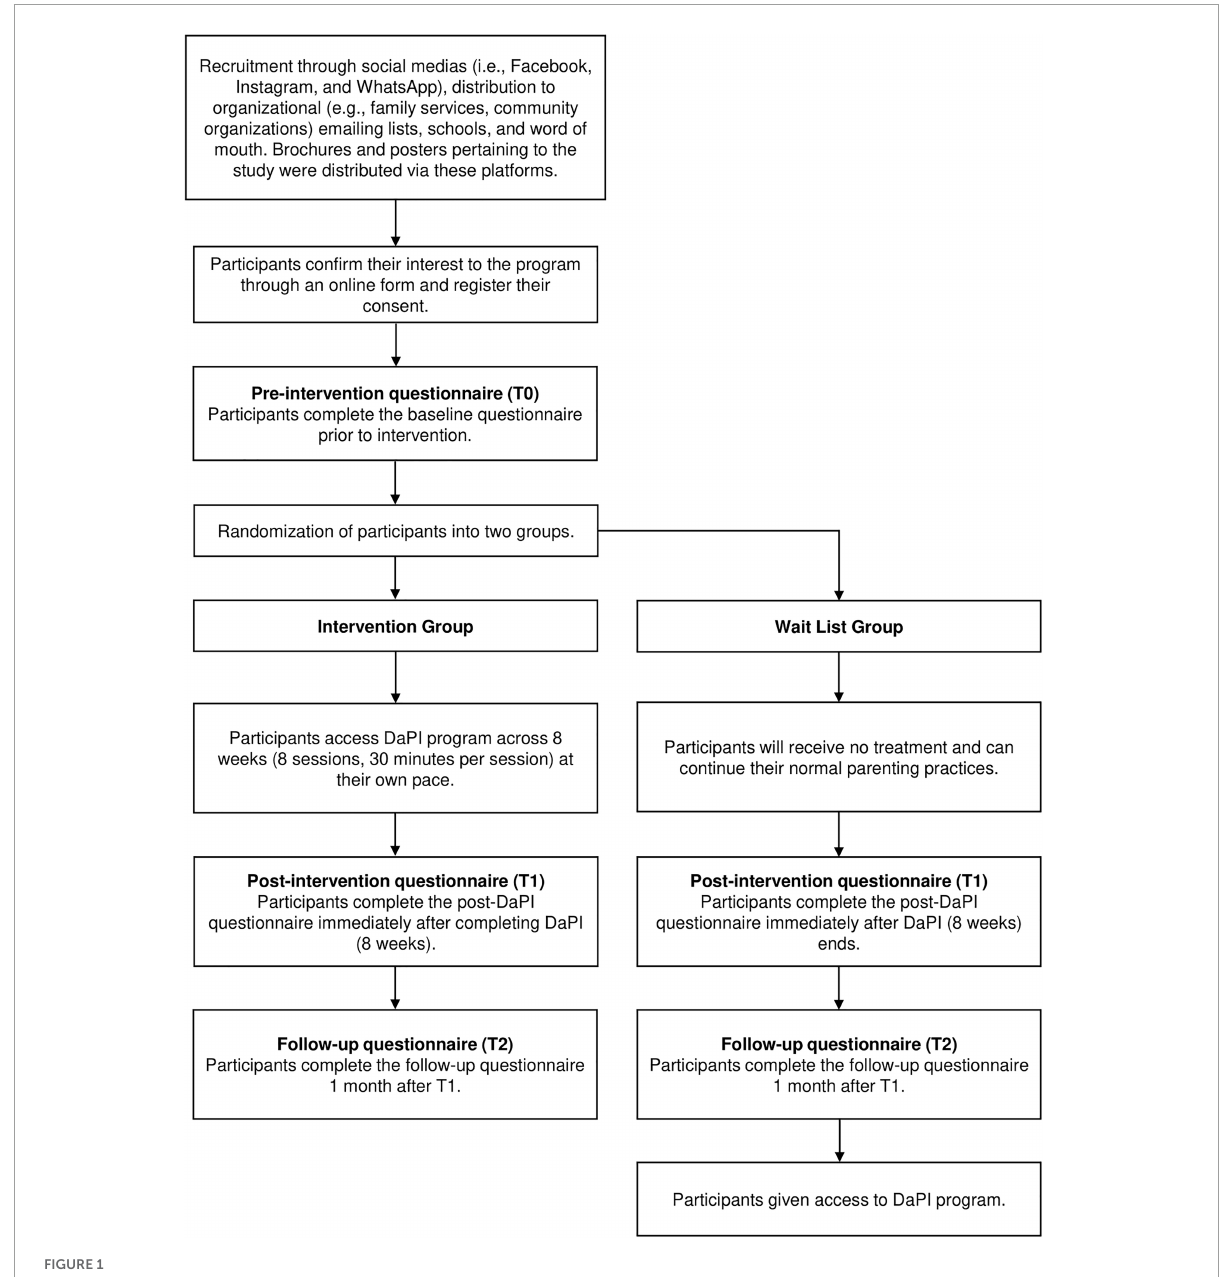
FIGURE1 Participant flow through the study.